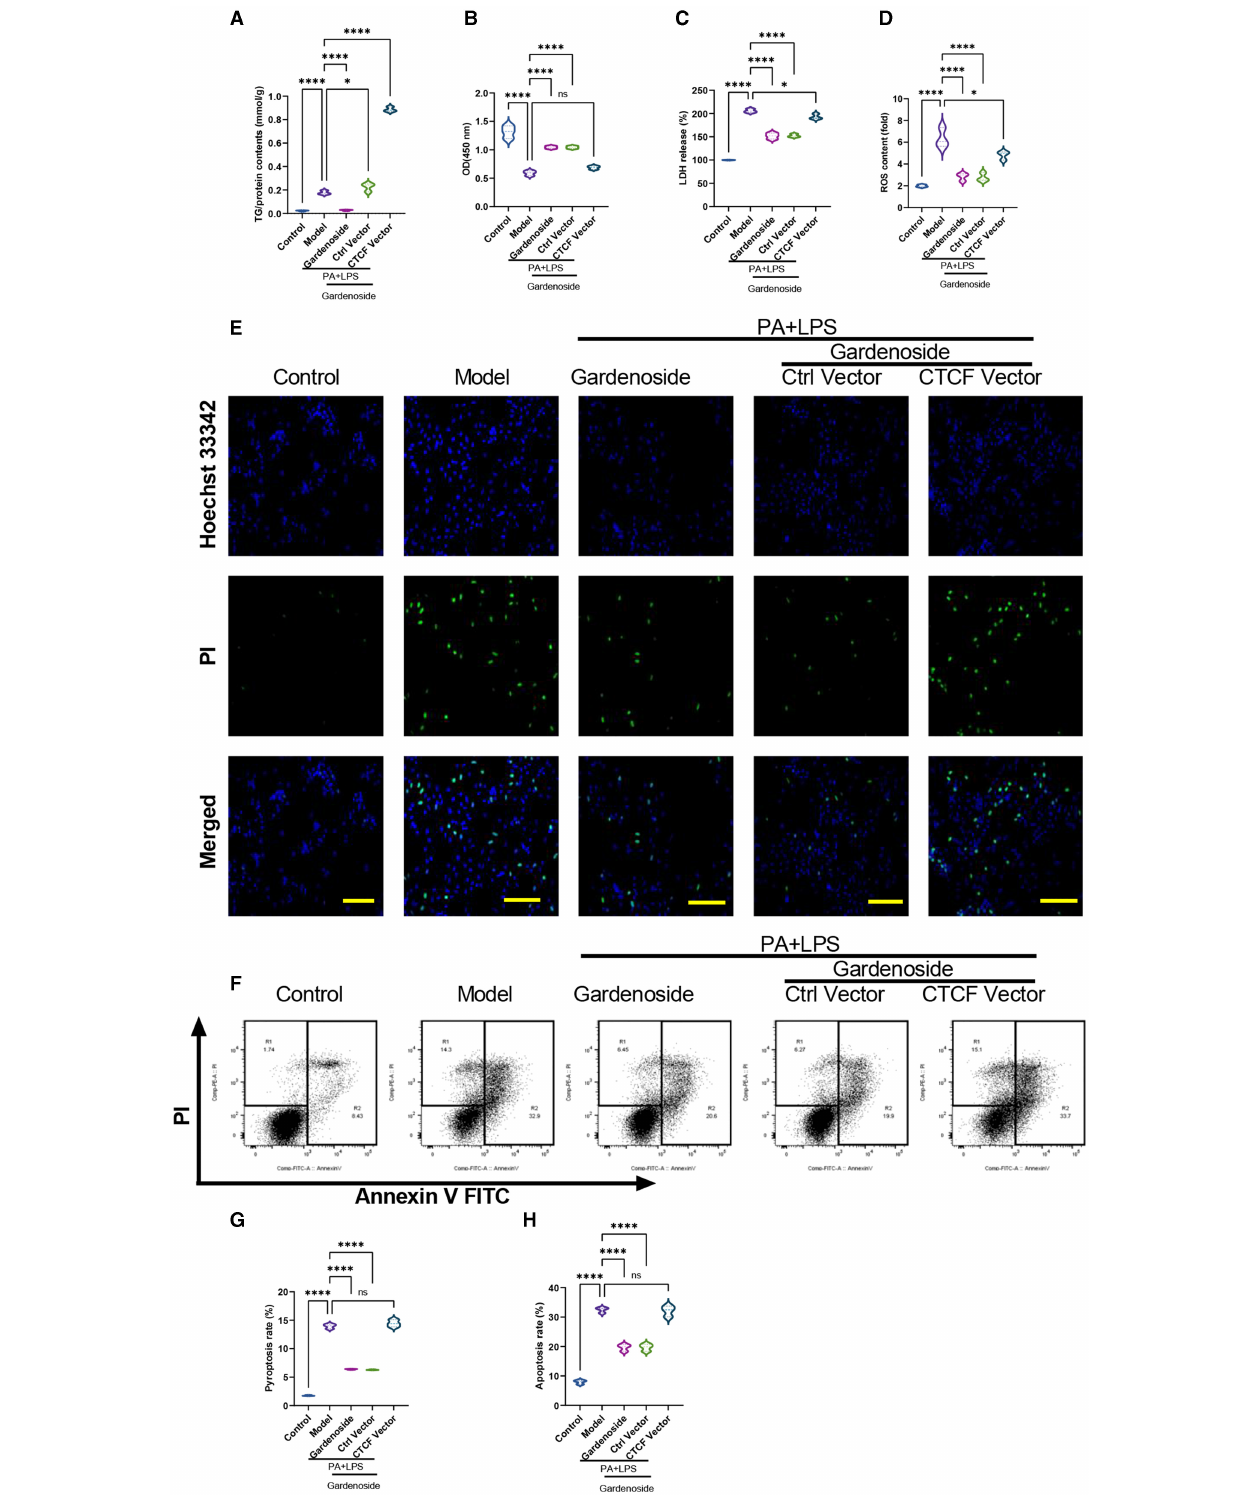
FIGURE 5 | CTCF overexpression counteracted the effect of gardenoside on lipid accumulation, intracellular ROS, LDH release, apoptosis and pyroptosis in the cell model of NAFLD. (A) Detection of the TG content in AML cells of indicated groups. (B) Detection of cell proliferation in AML cells of indicated groups. (C) Detection of